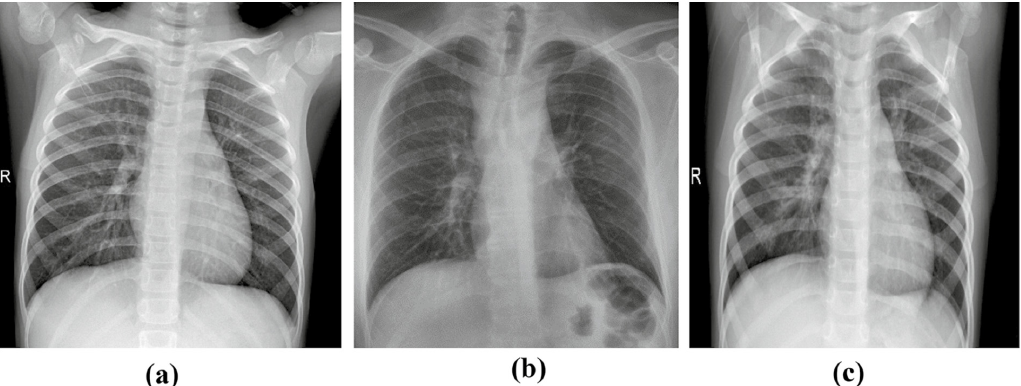
Figure 4. Samples of frontal-view chest X-ray images from the dataset: ( a ) normal case, ( b ) COVID-19 case, and ( c ) pneumonia.